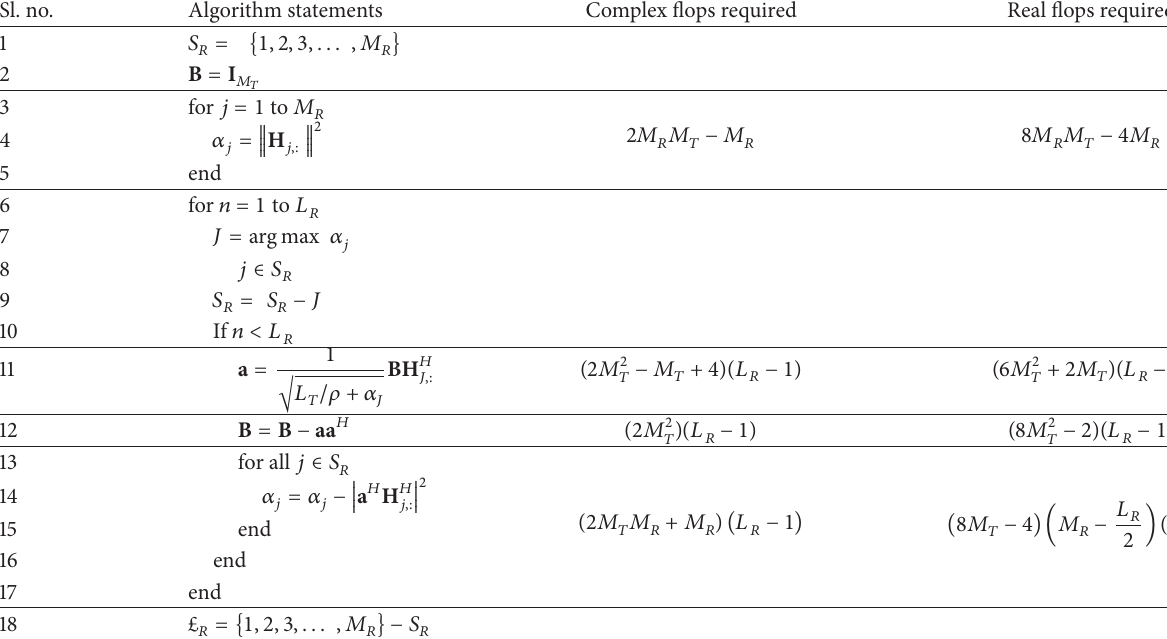
Table 5: Complexity break-up of Gharavi-Alkhansari and Gershman algorithm [11]. Sl. no.